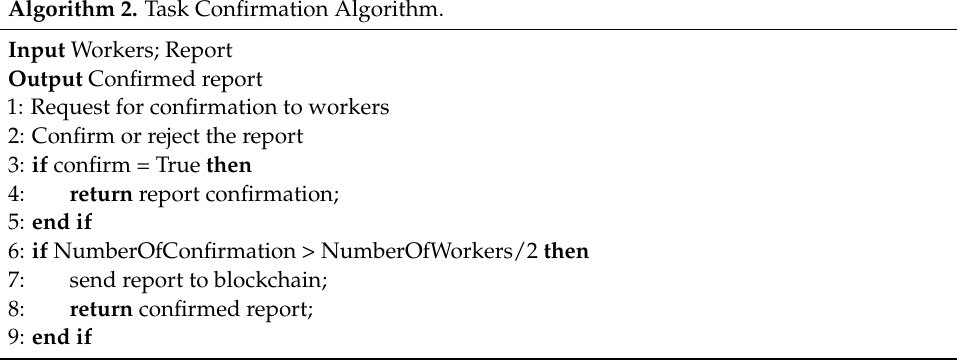
Algorithm 2. Task Confirmation